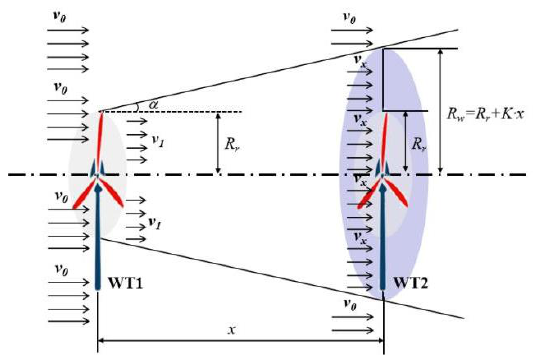
Figure 1. Schematic of Jensen’s wake model [26].